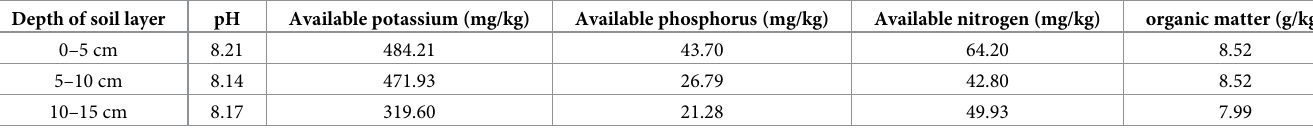
Table 2. The basic physical and chemical properties of soil. Depth of soil layer pH Available potassium